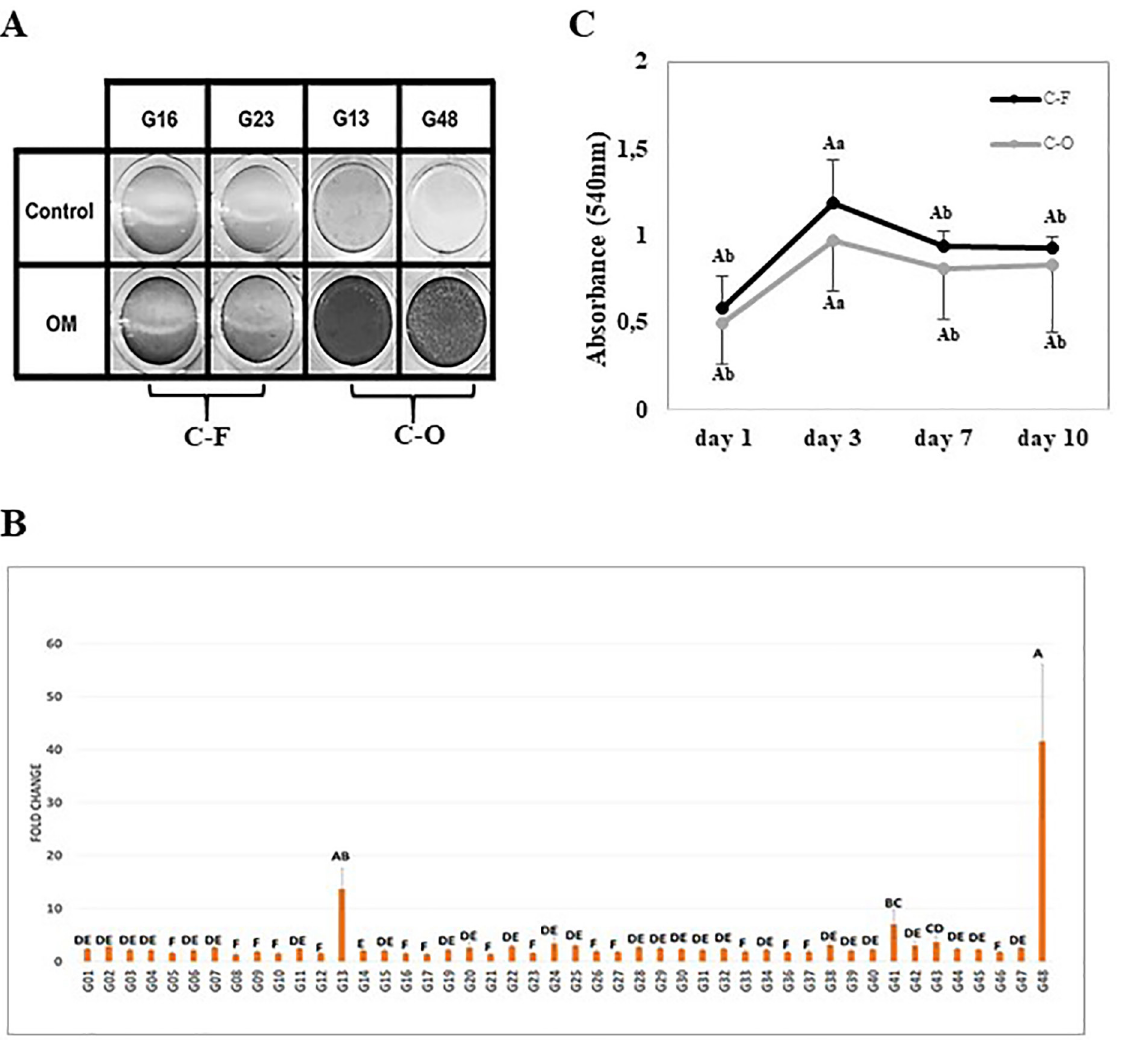
Figure 2- PDL-CD105+- derived cell clones. (A) Alizarin Red staining showed that G16 and G23 clones (C-F cells) could not form mineralized deposits in vitro , whereas G13 and G48 clones (C-O cells) showed capacity of biomineralization in vitro when cultivated under osteogenic induction (OM). (B) Clones G13 and G48 showed significant quantification of AR-S compared to the other clones. Data are presented as fold increase relative to non-induced controls. Statistical significance was determined using ANOVA/Tukey’s test (p<0.05). (C) Metabolic activity as an indicator for cell viability was measured with MTT assay at the following time points: 1, 3, 7, and 10 days. Distinct capital letters represent intragroup statistical differences, and distinct lowercase letters represent intergroup statistical